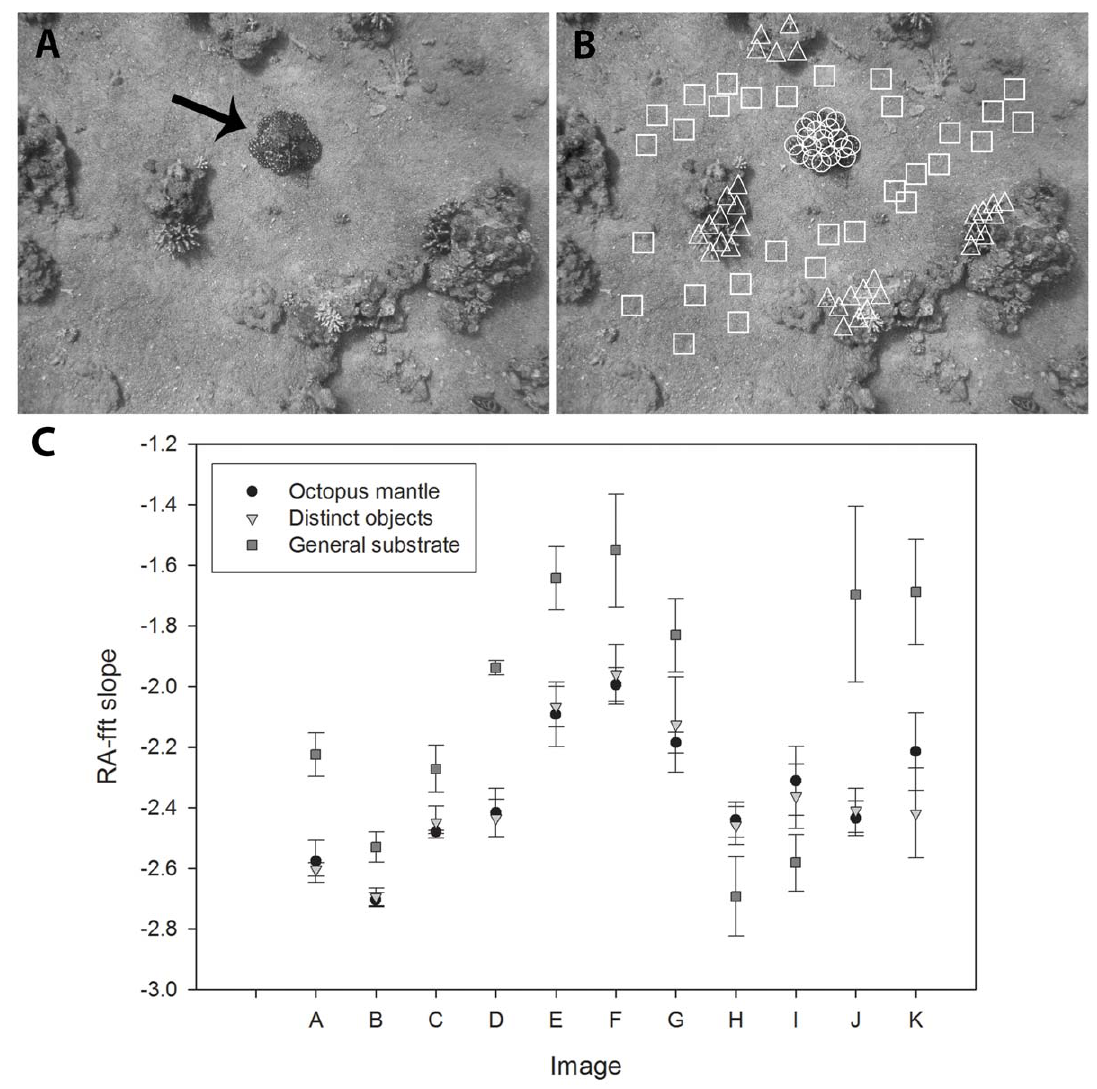
Figure 2. Octopus background matching examined using the multi-point method. (A) Grayscale image of a camouflaging O. cyanea , marked with an arrow. (B) Same image as in A showing the 30 samples in each of the three groups marked as: ( # ) Octopus mantle, ( n ) Distinct objects, ( % ) General substrate. (C) Octopus similarity to background sections using the ‘‘Multi-point’’ method. For each image analyzed (A–K), means 6 SD are presented for each of the three groups. In all images, the substrate was significantly different from both octopus-mantle and distinctive objects (Kruskal-Wallis test; P , 0.01). Different octopuses presented different patterns (Kruskal-Wallis test; P , 0.01) and yet resembled specific objects (Mann-Whitney U test; P . 0.05). Images A and B are the same images presented in Figures 1 and 2a,